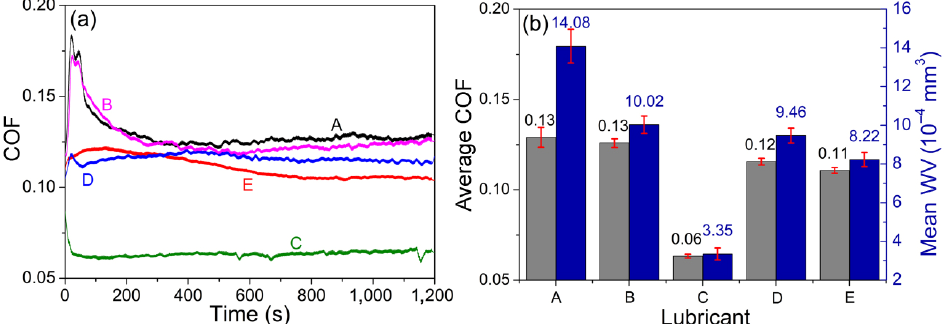
Fig. 14 (a) COF curves, (b) average COF and mean WV of the disks lubricated with (A) PEG200, and (B) A-g-CNPs (C) C-g-CNPs dispersions (0.7 wt%) in PEG200, (D) [C 16 -MIm]Cl, and (E) [C 16 -HA]Na solutions (0.7 wt%) in PEG200 under the conditions of 100 N and 20